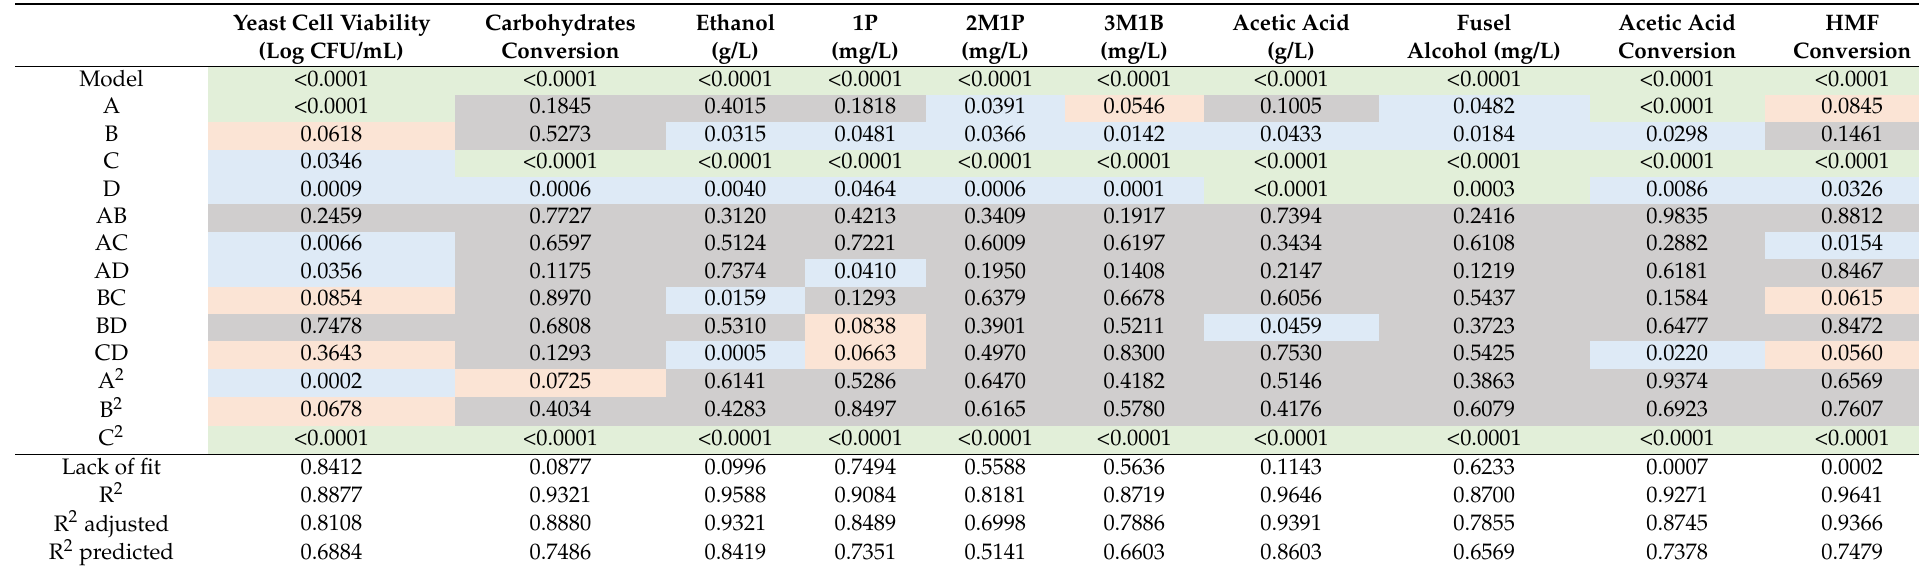
Table 4. ANOVA results for the adjusted variables to response optimization in response to pH (A), stirring (B), temperature (C), and hydrolysis (D).